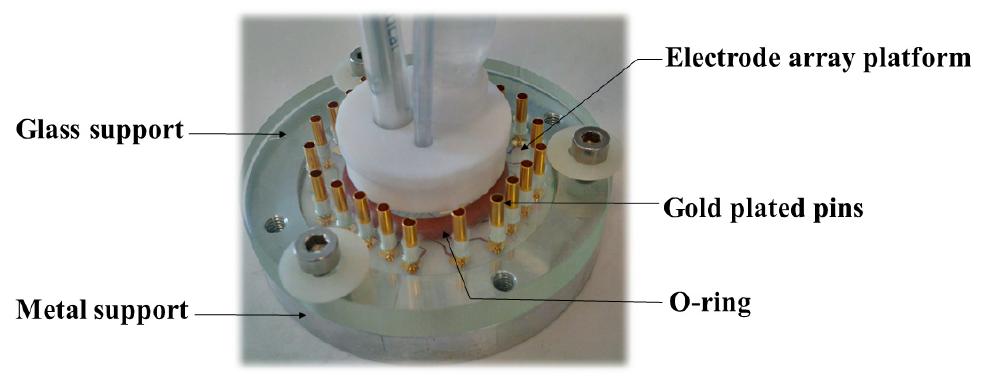
Figure 1. Electrochemical cell used for Electrodes Array for Sampled-Current Voltammetry (EASCV)